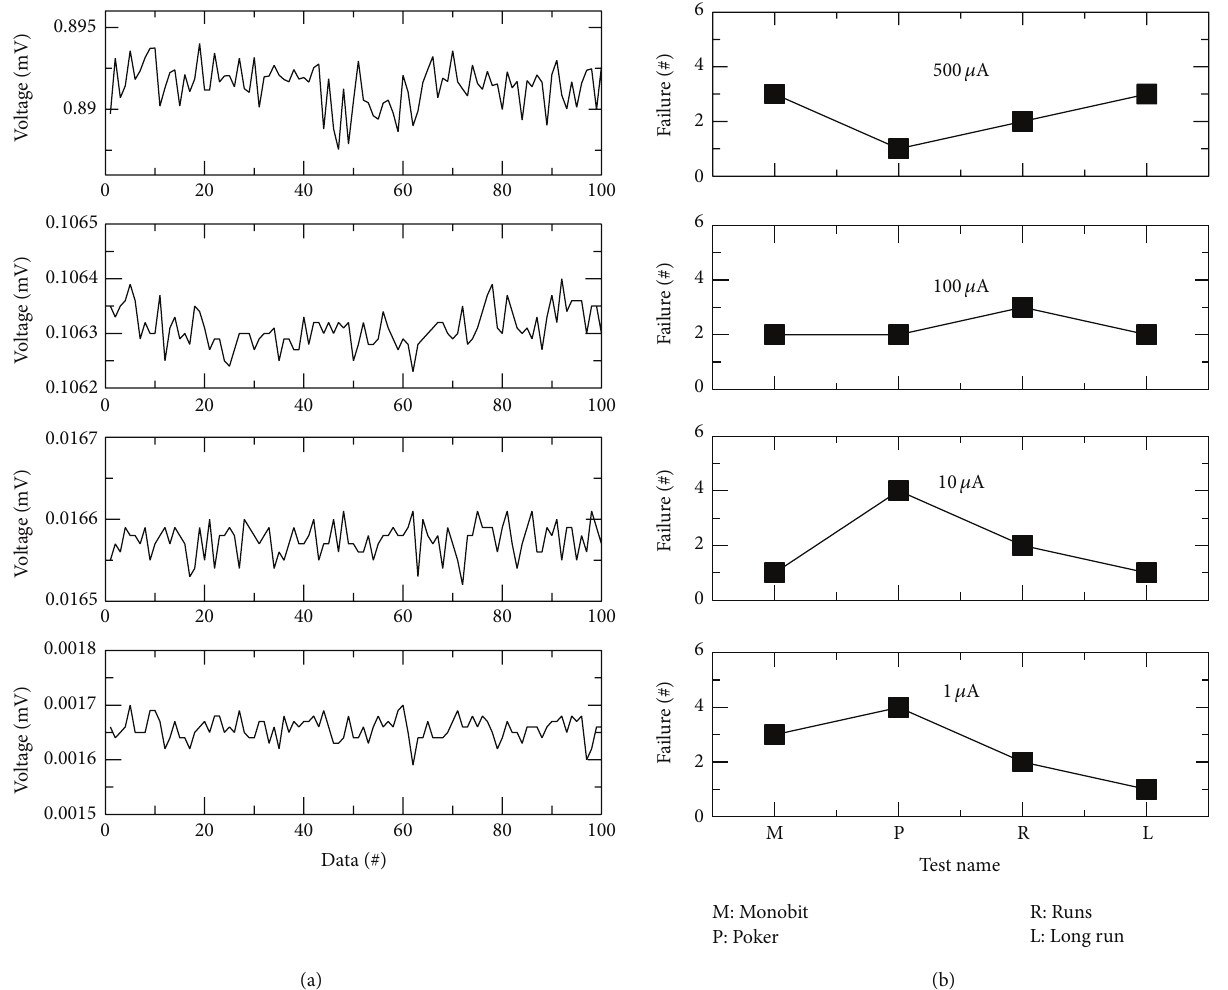
Figure 4: Randomness tests with various current amplitudes. (a) The temporal electrical output signals for the four currents (1, 10, 100, and 500 𝜇 A). (b) The evaluation of the randomness at each current